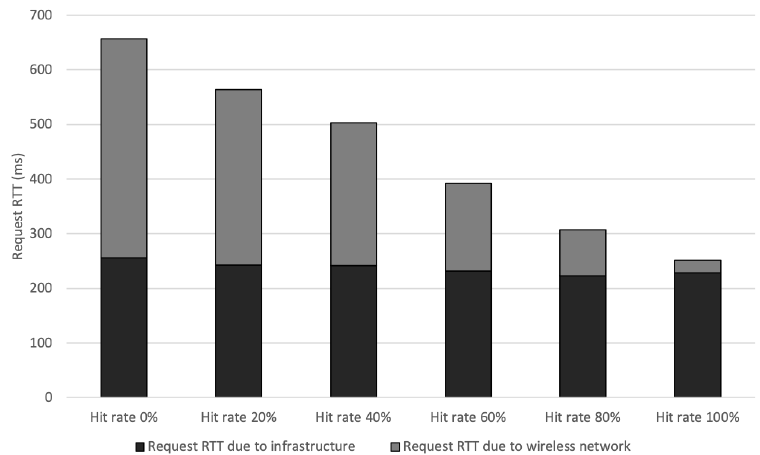
Figure 8. Request RTT per vOBU hit rate attending the network segment involved.